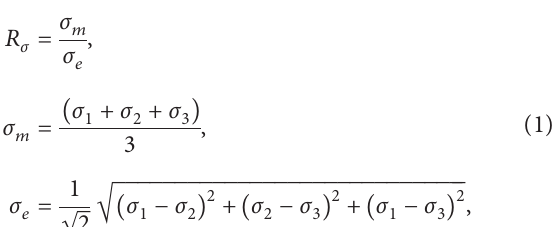
Figure 5: Hysteretic curves. (a) WF-1A. (b)